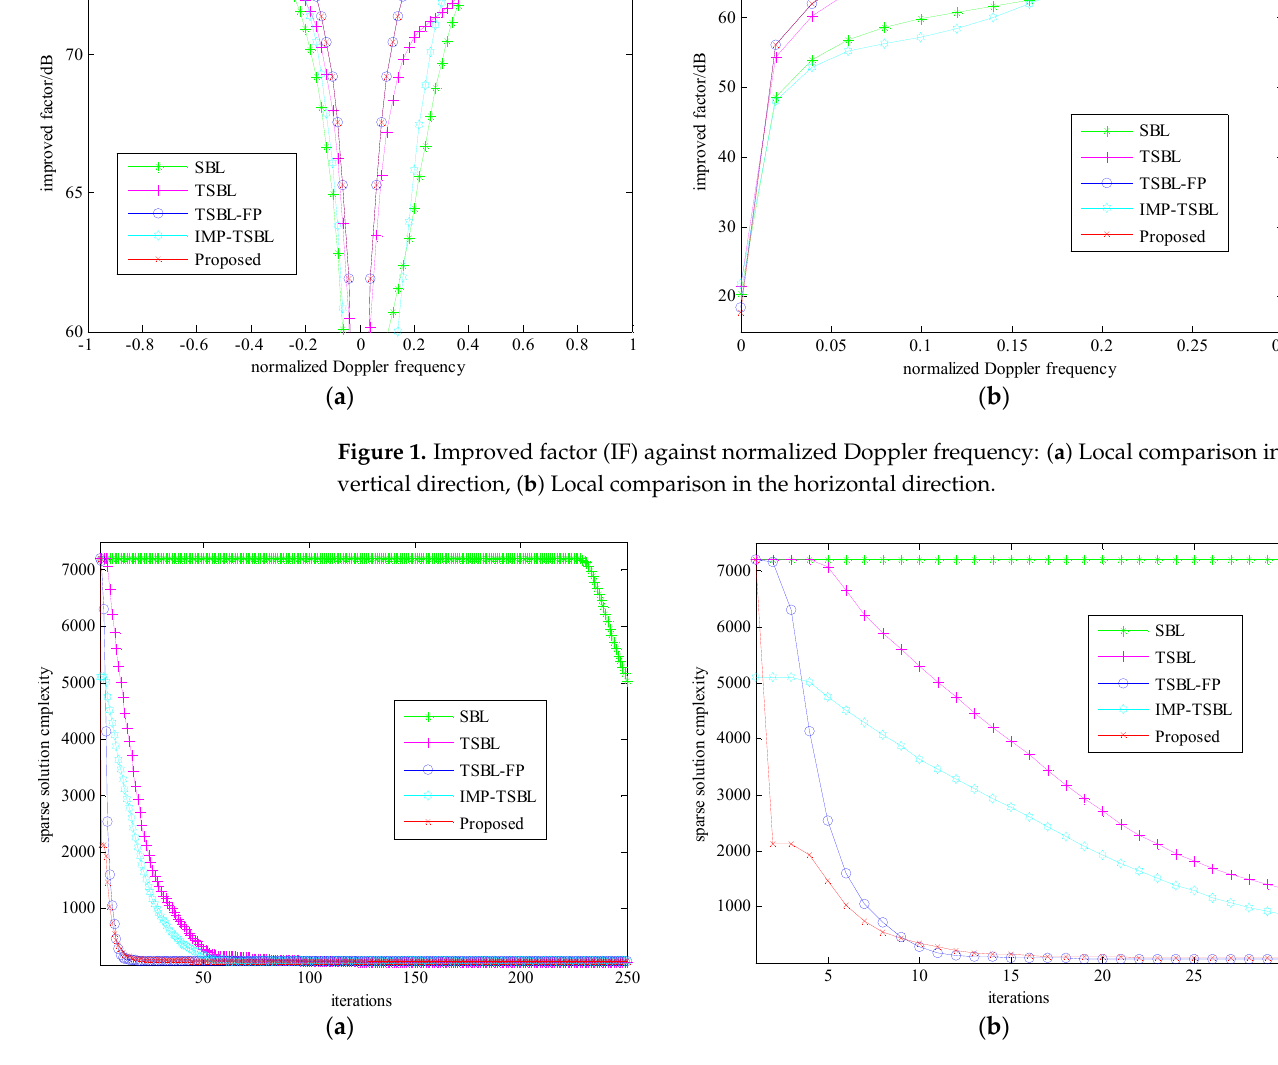
Figure 2. Computational complexity of different methods in the sparse solution calculation: ( a ) Comparison with 250 iterations, ( b ) Comparison with 30 iterations.